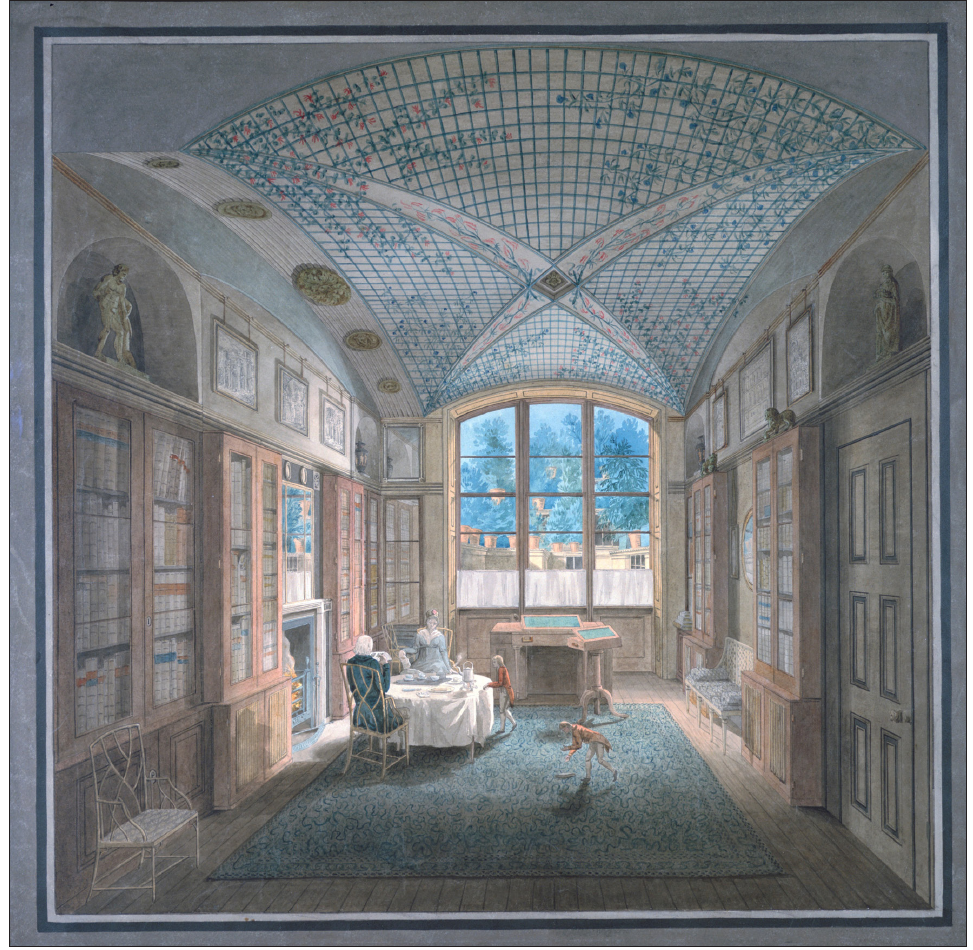
Fig. 1 : Joseph Michael Gandy, View showing the Soane family in the breakfast room at